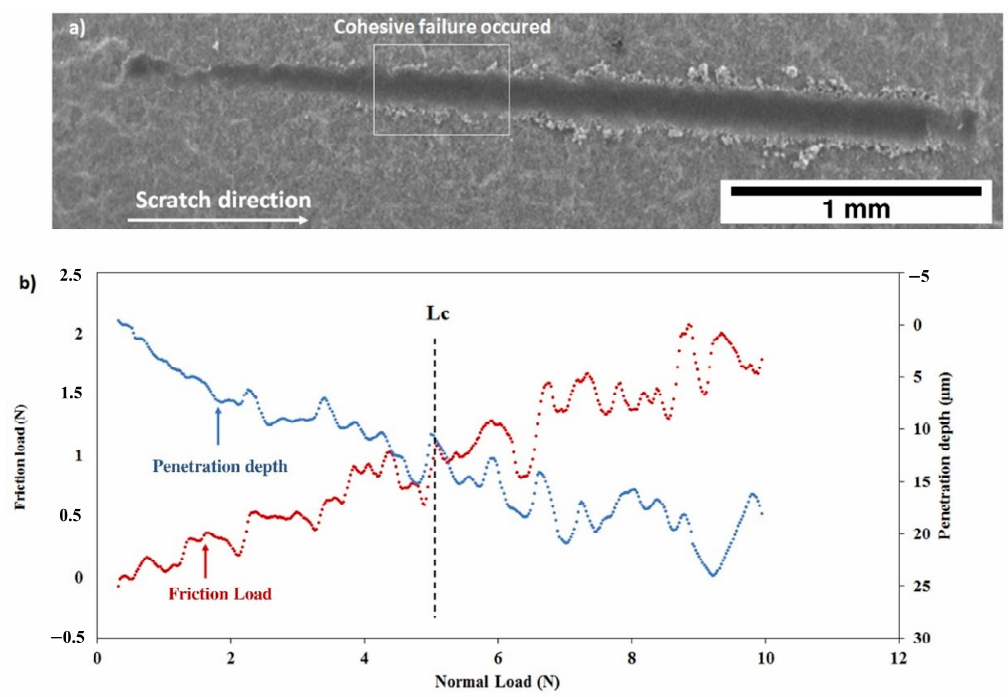
Figure 14. Scratch test of the as deposited C30 coating: ( a ) SEM micrograph of the scratch and ( b ) friction load and penetration depth as a function of normal load.